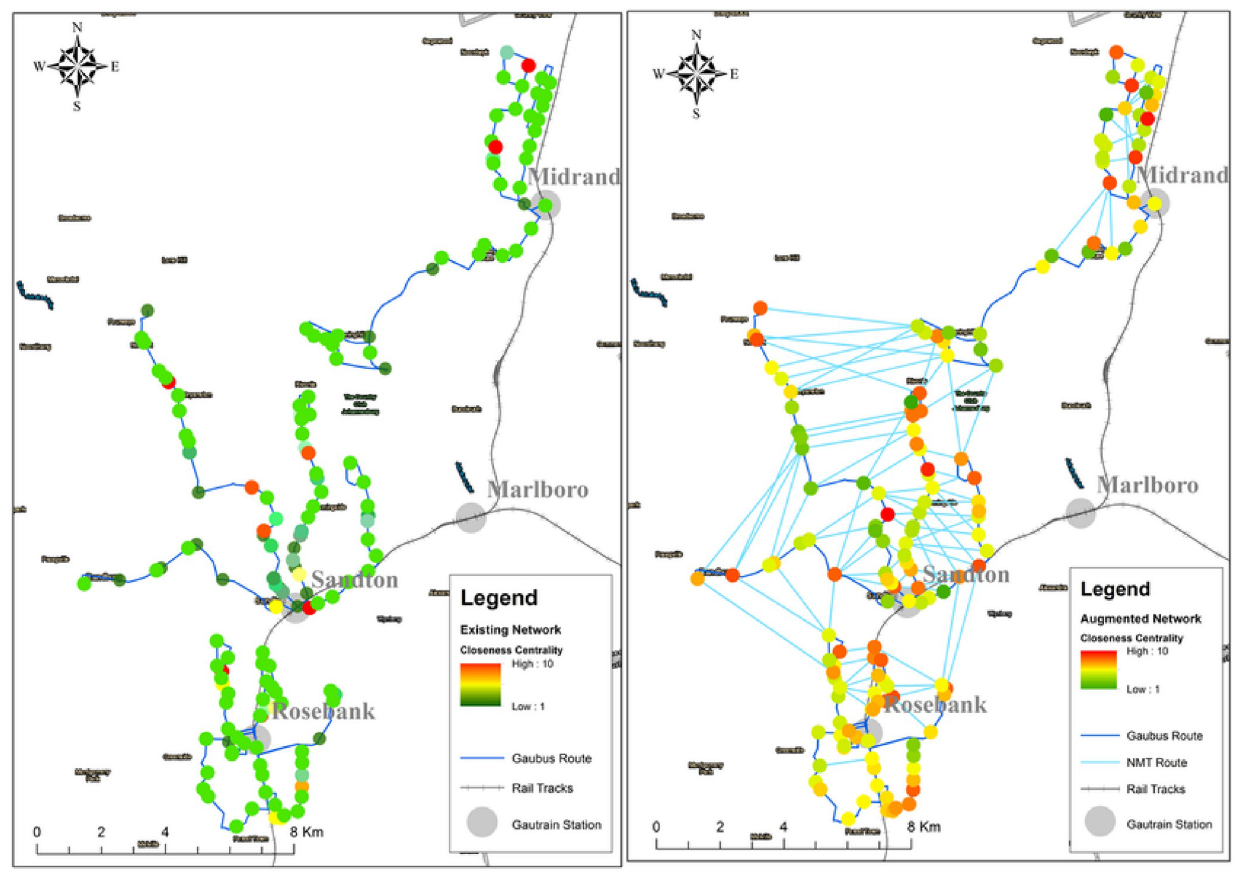
Fig 15. Closeness centrality: Existing network (left) and augmented network